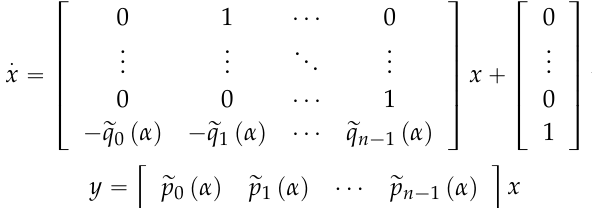
Figure 3. Membership function for p̃ 0 , q̃ 0 , q̃ 1 , q̃ 2 , q̃ 3 and q̃ 4 .